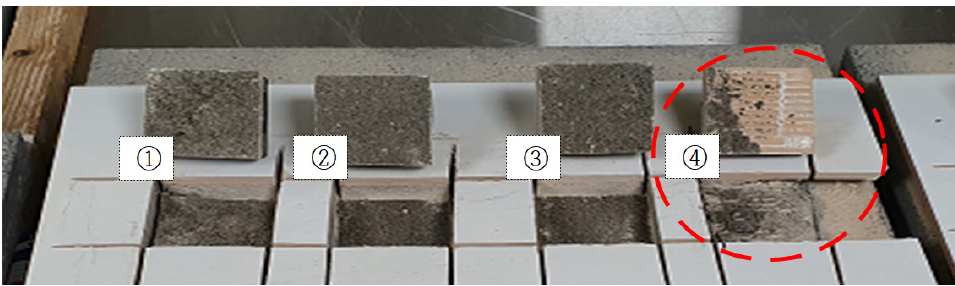
Figure 8. Tile adhesion state after ISO standard adhesion testing.